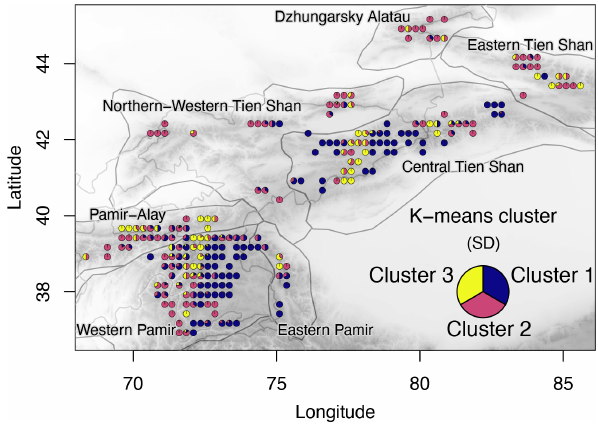
Figure 5. The k -means clusters according to mass balance variabil- ity (standard deviation – SD) for the 2000–2018 period from Baran- dun et al. (2021a). Classes represent glaciers with different variabil-